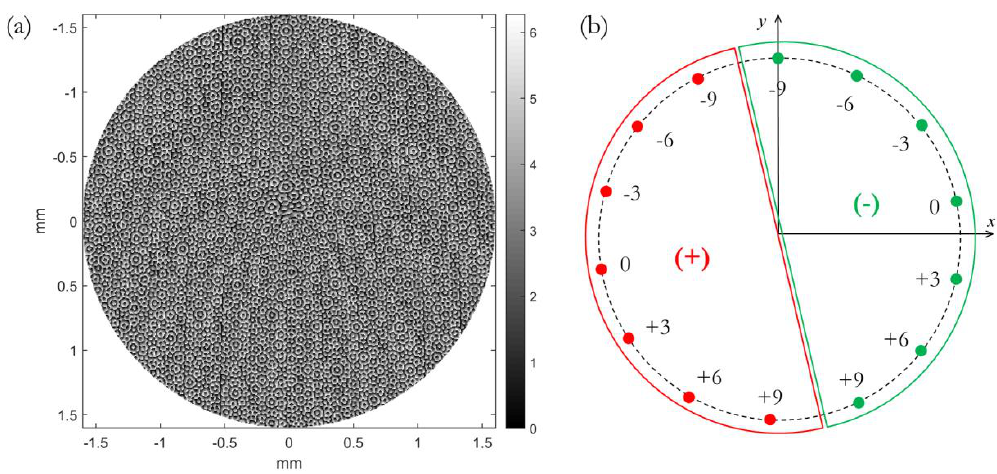
Figure 2. ( a ) Numerical phase pattern for the sorting of OAM beams in the range {−9, −6, −3, 0, +3, +6, +9}, with 16 phase levels. Pixel size: 6.125 μm × 6.125 μm. Radius size: 256 pixels. ( b ) Far-field channel constellation for the given OAM set and circular polarization states.